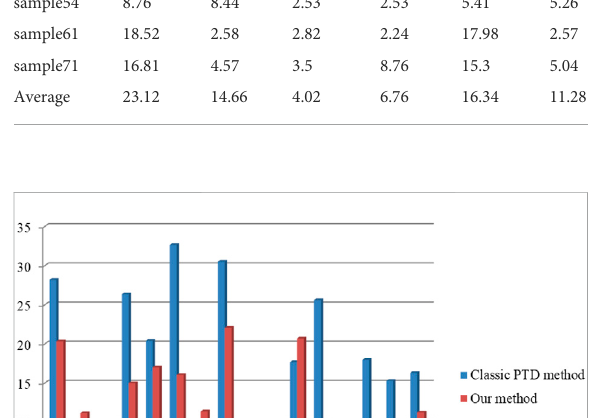
FIGURE 11 Type Ⅱ error comparison chart.